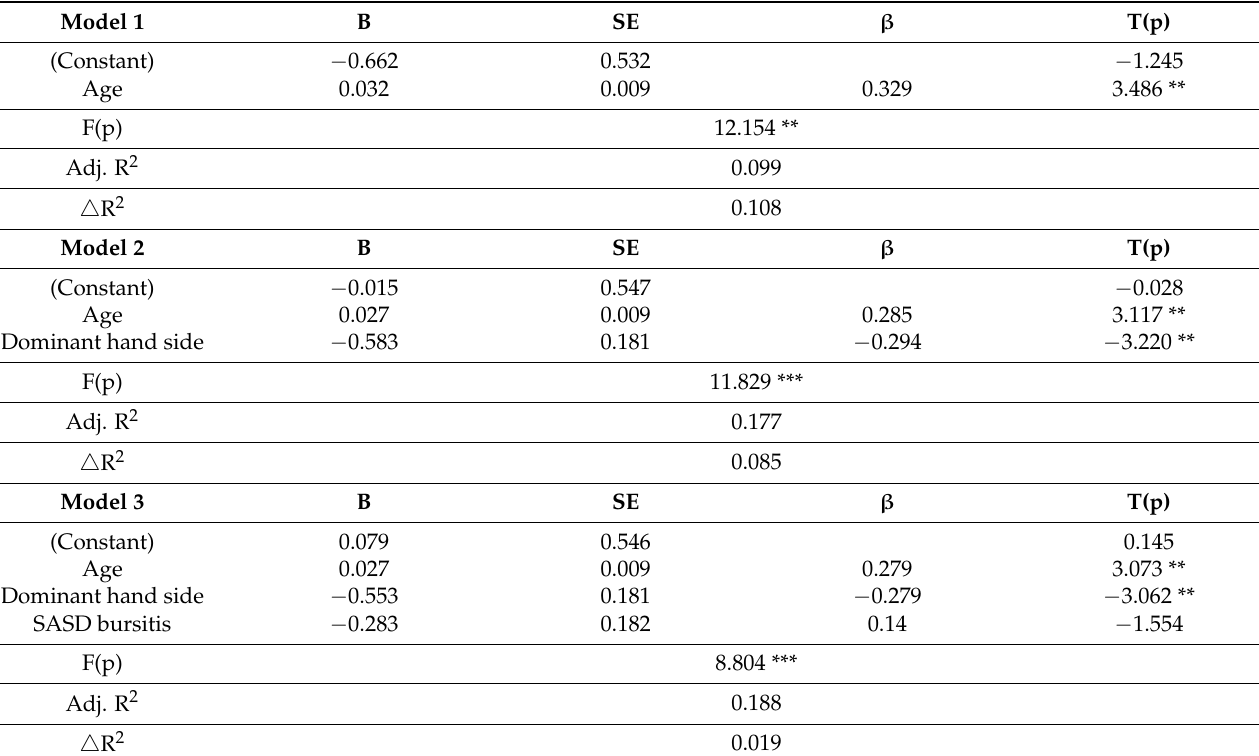
Table 5. Hierarchical regression analysis.